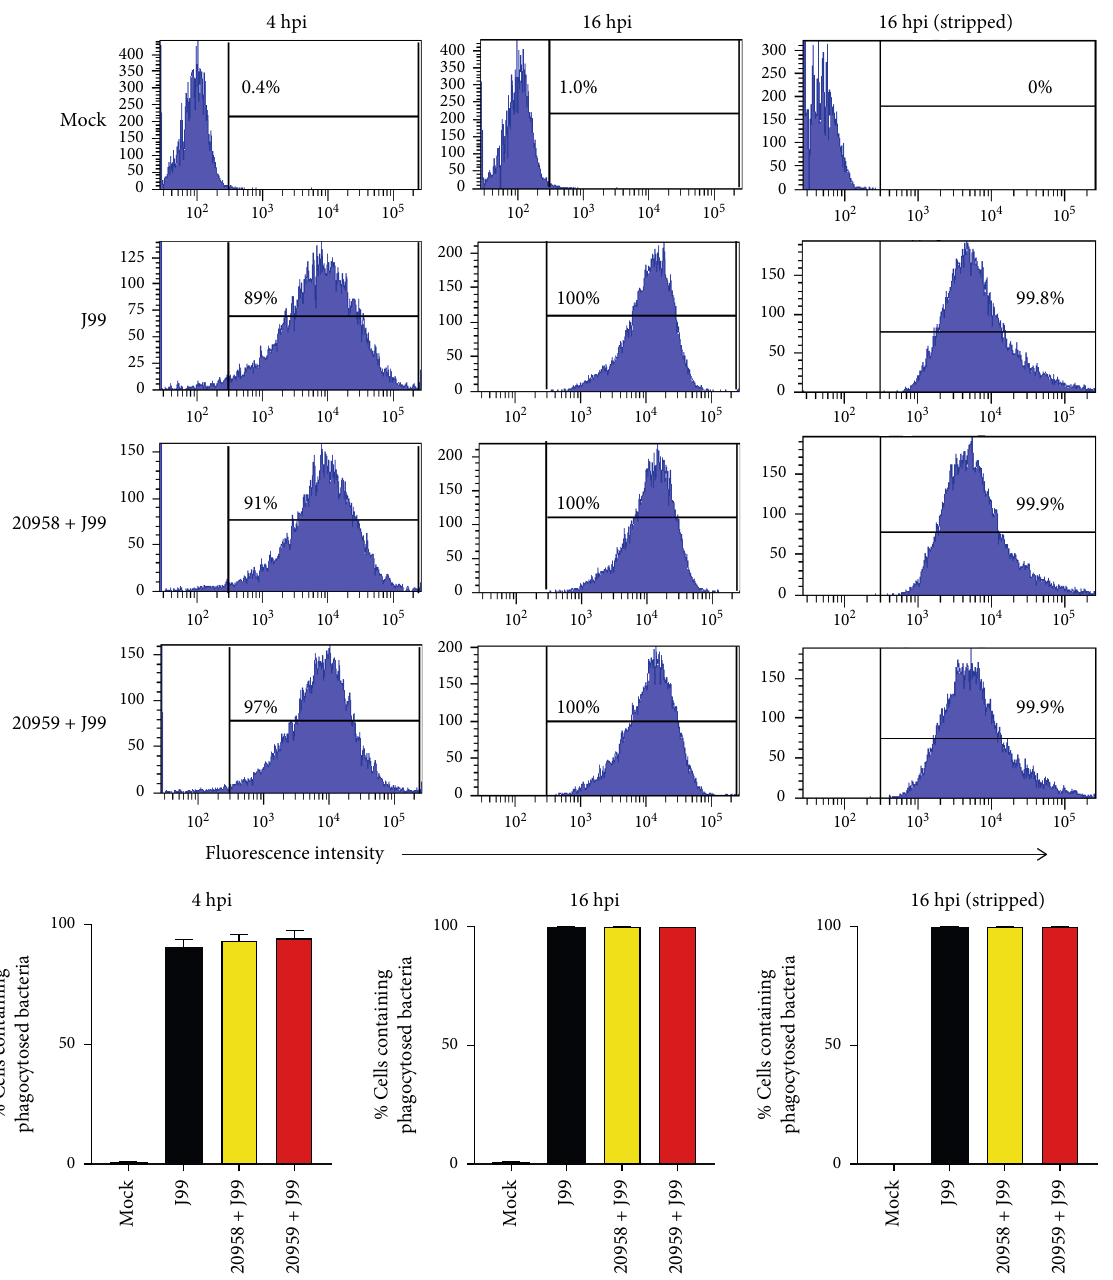
Figure 6: Phagocytic function of THP-1 macrophage is unaltered upon inhibition of both TLR7 and TLR8 mediated signaling. THP-1 cells were uninfected (mock), infected with H. pylori J99 strain, or infected and treated with TLR7 inhibitor (ODN20958+J99) or TLR7/8 inhibitor (ODN20959 +J99), at MOI 50 for 4 hours or MOI 10 for 16 hours. Some cells were stripped o ff extracellular bacteria before analysis. Fluorescent intensity was examined by fl ow cytometrical analysis. (a) Histogram showing fl uorescent intensity. (b) Bar charts showing the average percentages of cells containing FITC-labeled bacteria. Data is representative of three independent